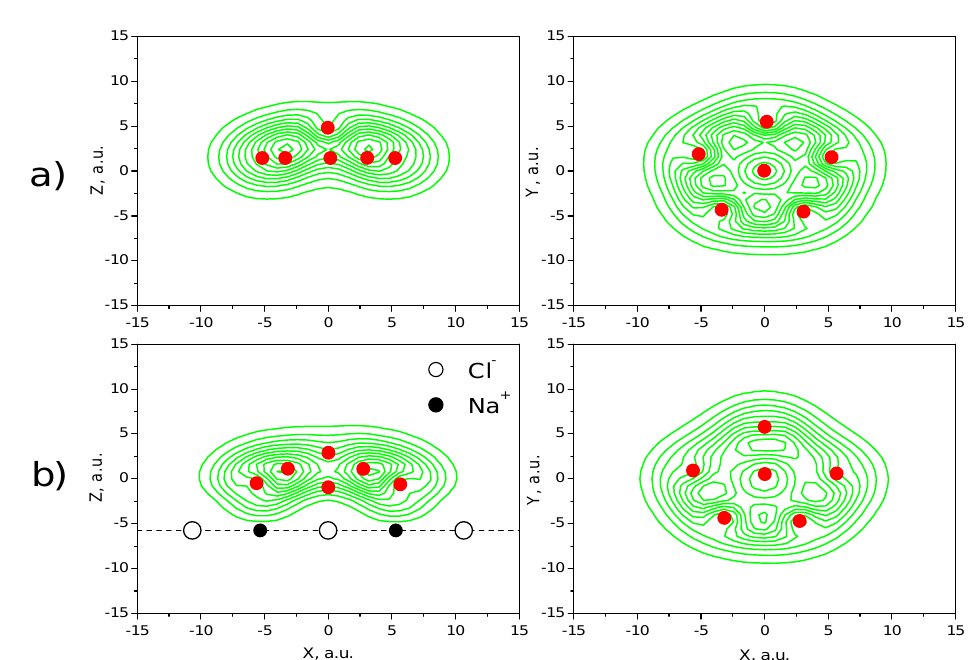
Figure 1: Ground state configuration of (a) free Na